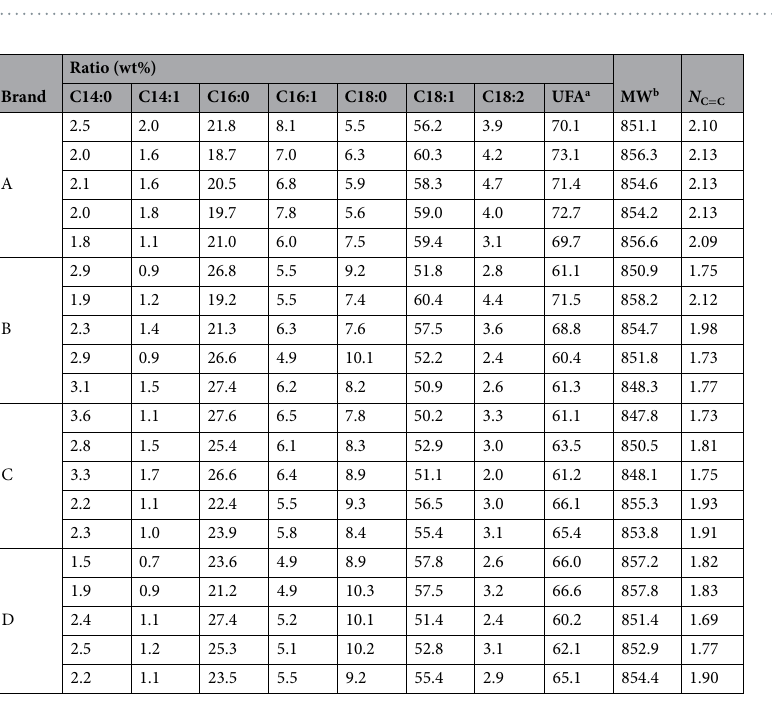
Figure 2. Triacylglycerol (TAG) and its unsaturation degree ( N C = C ) in the sirloin of Japanese Black cattle. ( A ) 1 H NMR spectra of the CDCl 3 extract of a sirloin sample after 2-week aging. Each signal is assigned to the proton represented by the italic and bold style ( H ) in the partial structural formula of TAG. ( B ) The N C = C values of the sirloin samples from four different brands. The data are presented as the mean ± standard error (SE; n = 5). Means with different letters (a and b) are significantly different at p < 0.05.